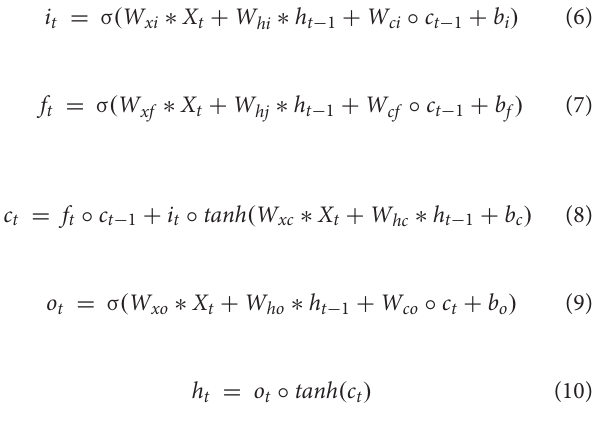
TABLE 1 | Partitioning of typhoons into training and validation sets. Partitioning